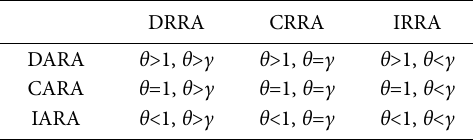
Table 1. Possible risk preferences under risk aversion ( θ >0, γ >0)